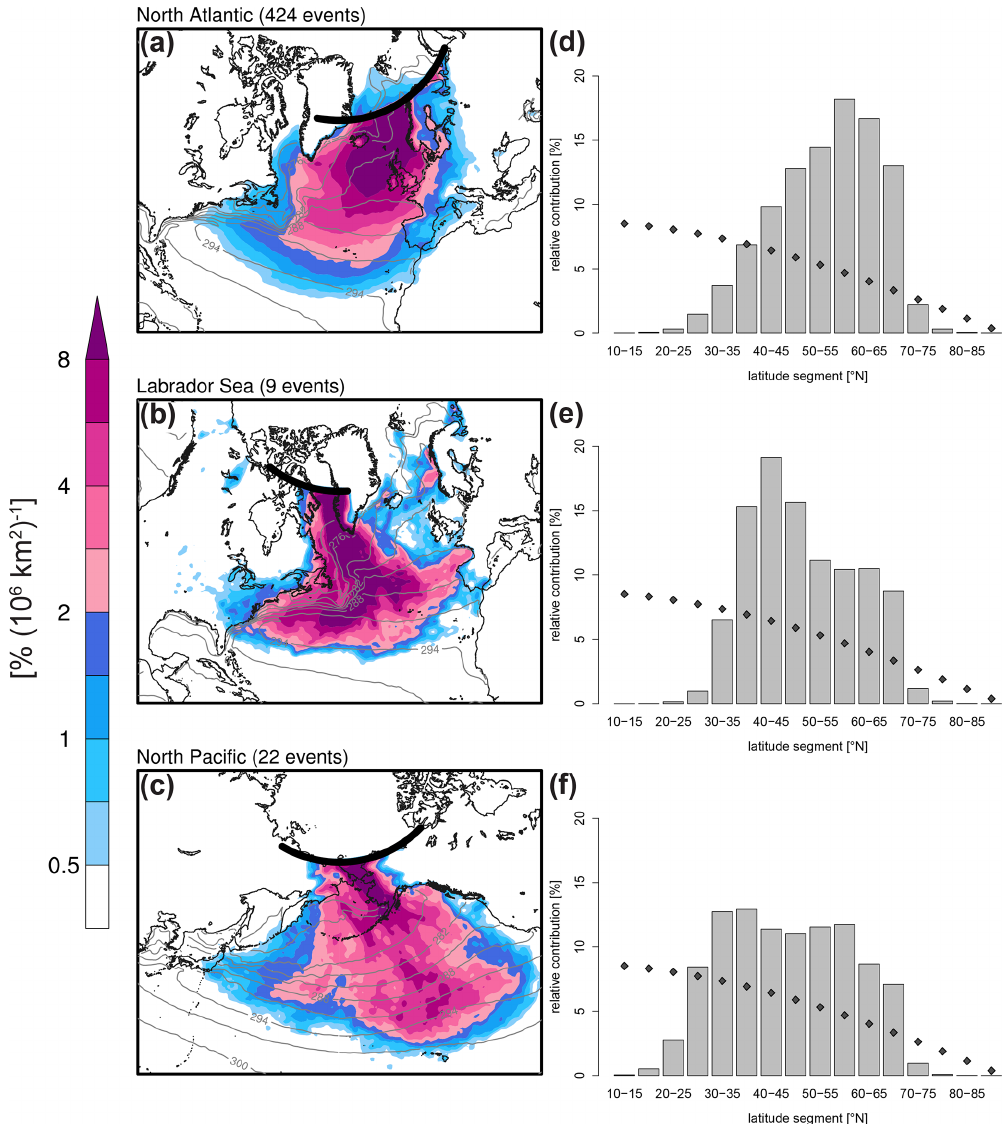
Figure 4. Moisture uptake (a–c) per area (as in Fig. 3) and (d–f) per latitude segment in percent of the total moisture transported across 70 ◦ N by the trajectories during moist-air intrusions in (a, d) the North Atlantic, (b, e) the Labrador Sea, and (c, f) the North Pacific. Additionally, diamonds in panels (d) – (f) indicate the fractional area of the Northern Hemisphere occupied by each latitude segment. Furthermore, solid black lines in panels (a) – (c) show the longitude ranges based on which moist-air intrusions are attributed to the respective sector. Gray contours show SST in intervals of